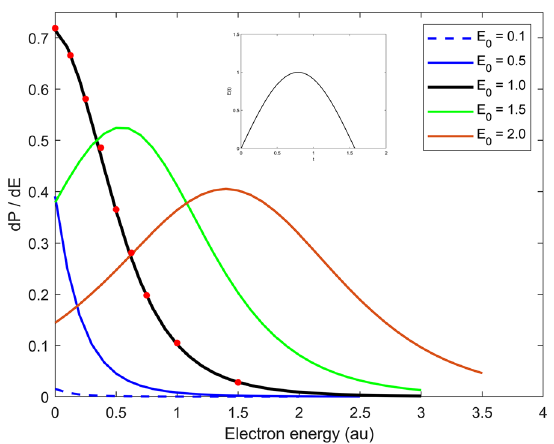
Figure 3. Ionization spektrum of H after irradiation with a half cycle pulse. The electric field of the half cycle pulse is depicted in the inlay: E ( t ) the half cycle pulse, the red dots are taken from Dimitrovski et al. 41 and correspond to q=1 of the First Magnus Approximation.